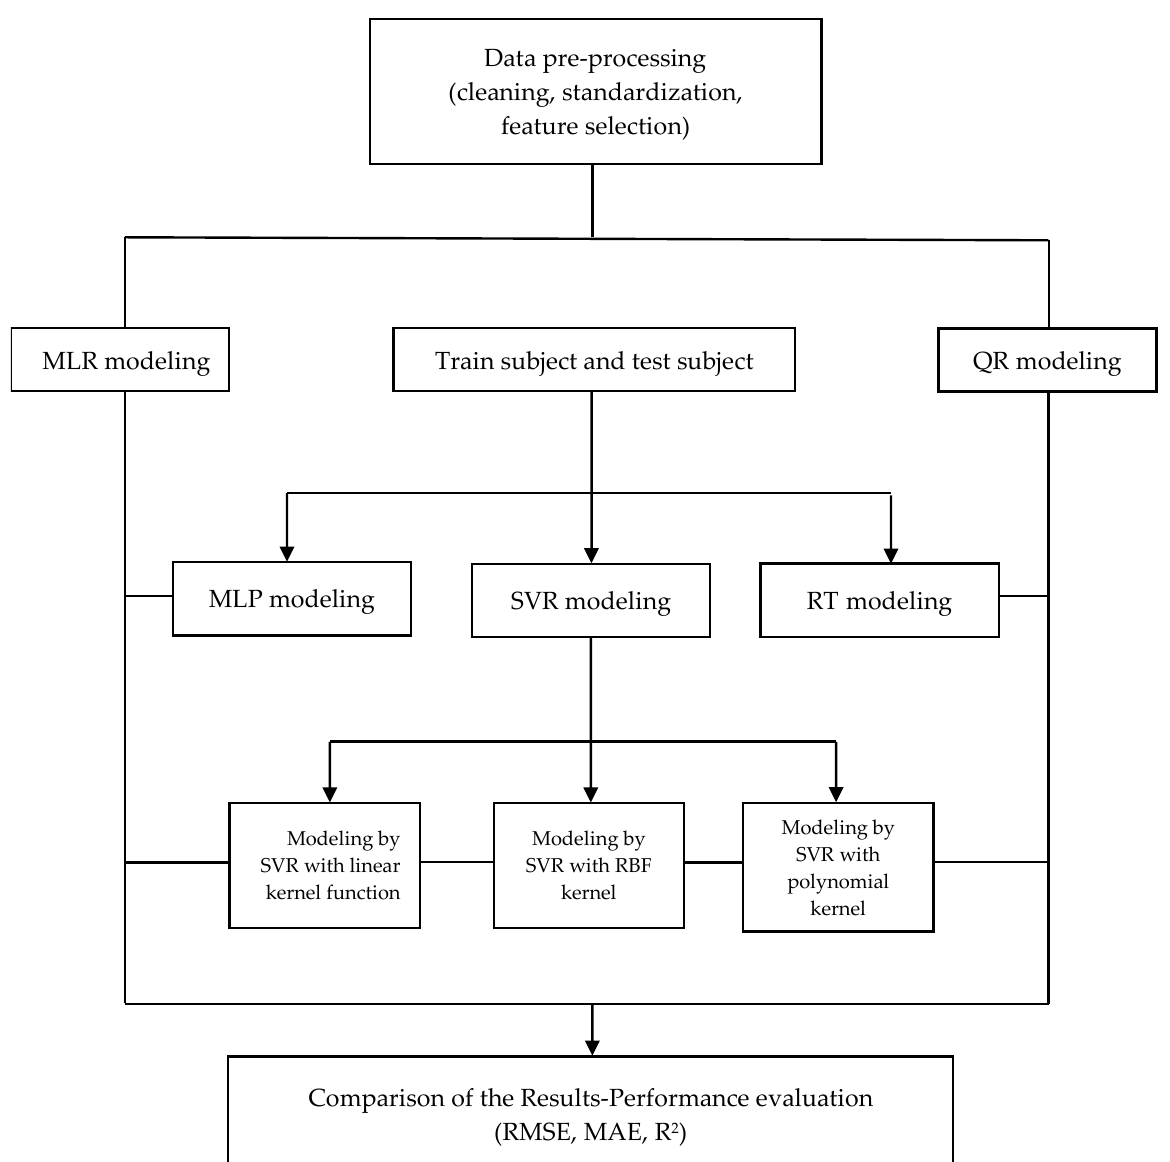
Figure 1. The prediction-modeling procedure of VO 2 max.